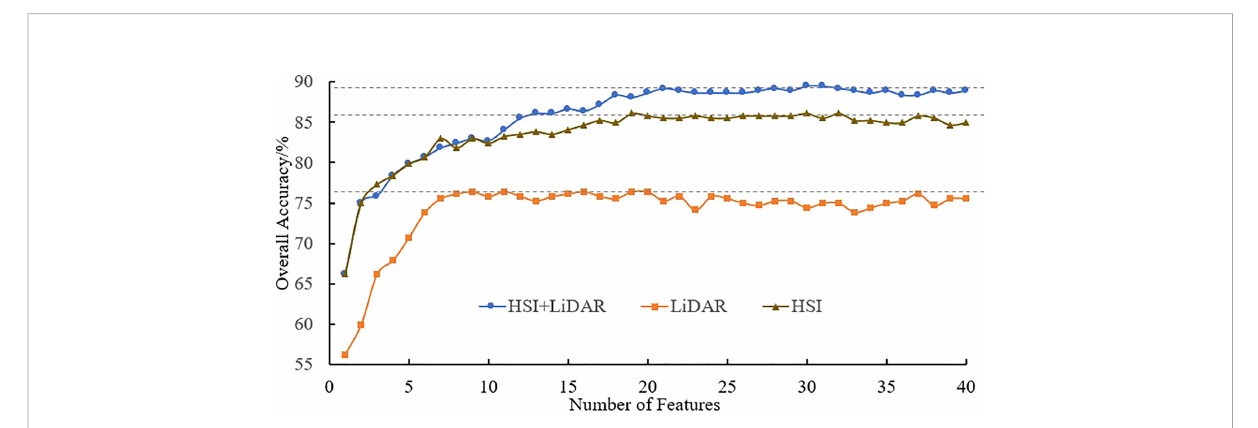
FIGURE 7 Accuracy of identi fi cation of tree